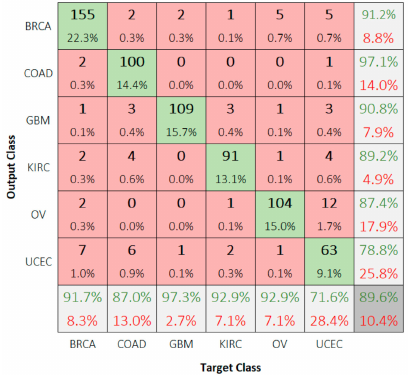
Figure 10. Confusion matrix for classifying the test dataset after training CNN6 using balanced oversampled training